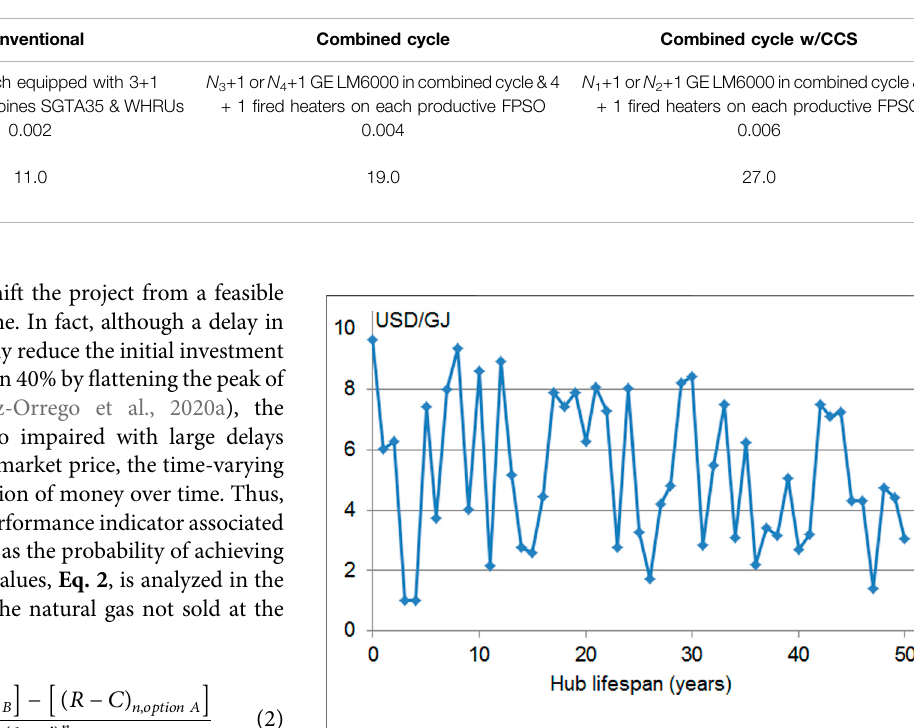
FIGURE 5 | Random pro fi le used for simulating the variation of the natural gas price over the project lifespan with a delay in entry of operation between FPSOs of 6 years. Different pro fi les can be generated based on the probability density function and other delays in entry of